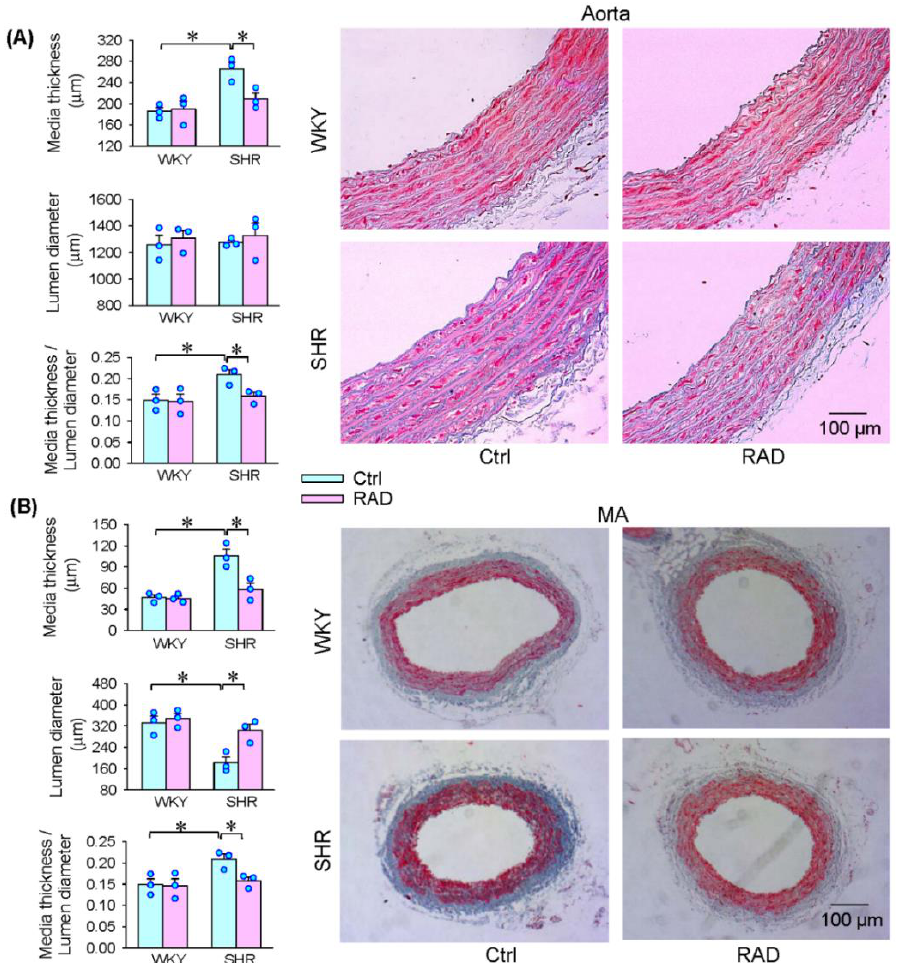
Figure 8. Effects of RAD on vascular remodeling of the aorta and mesenteric artery (MA) in WKY and SHR. Bar graphs show the Masson’s staining analysis for media thickness, lumen diameter and their ratio of arteries. Representative images showing Masson’s staining of the aorta ( A ) and MA ( B ). Values are mean ± SE. Two-way ANOVA followed by Bonferroni’s post hoc analysis were used for comparisons. * p < 0.05. n = 3 for each group.